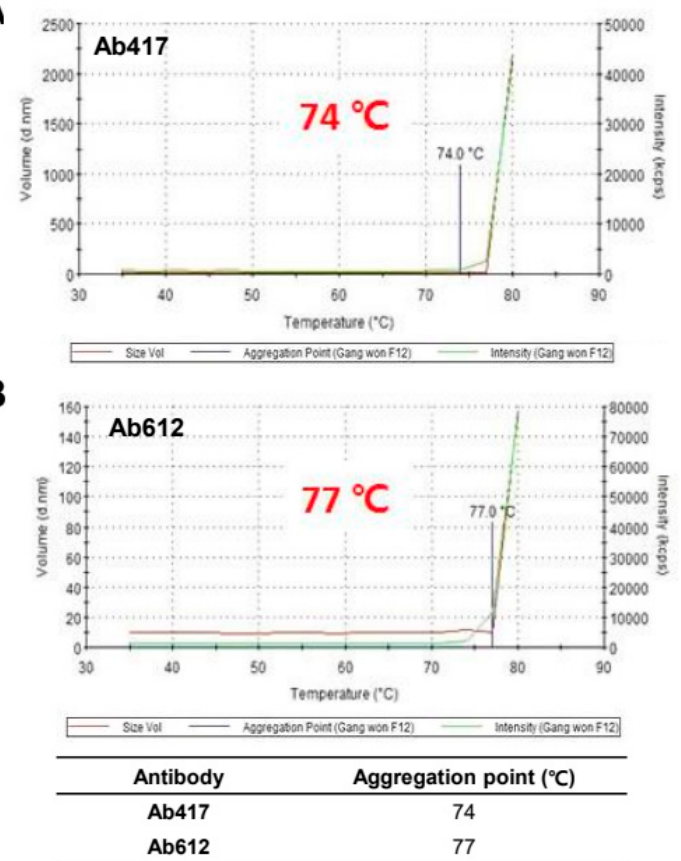
Figure 3. Assessment of thermal stability of Ab417 ( A ) and Ab612 ( B ) by DLS. The blue line indicates the starting point of protein aggregation.